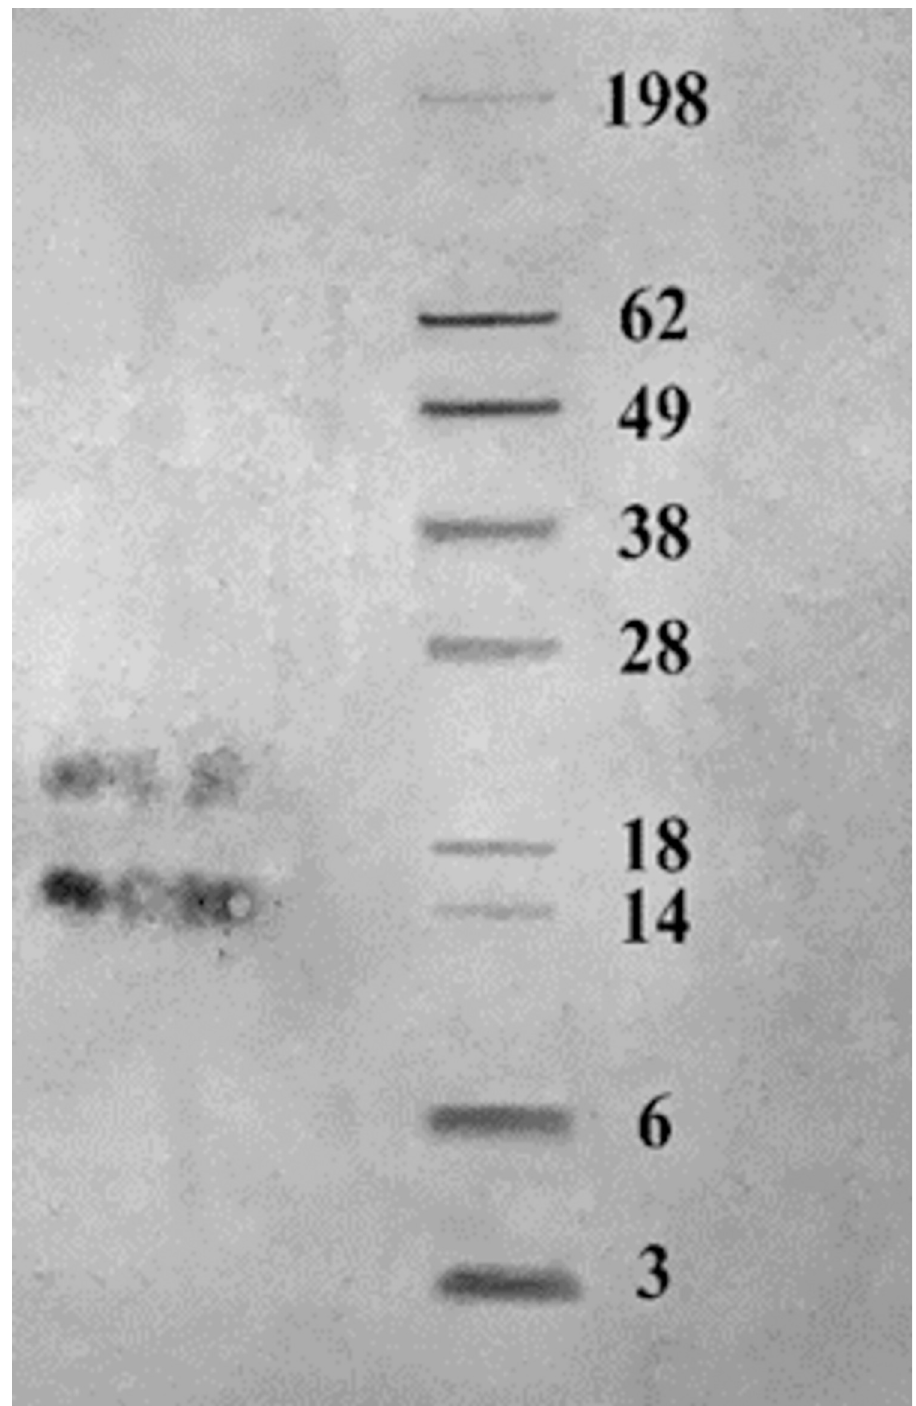
Fig 9. Two immunogenic bands obtained by western blot analysis of EVs using vaccinated mice sera as a source of primary antibody.